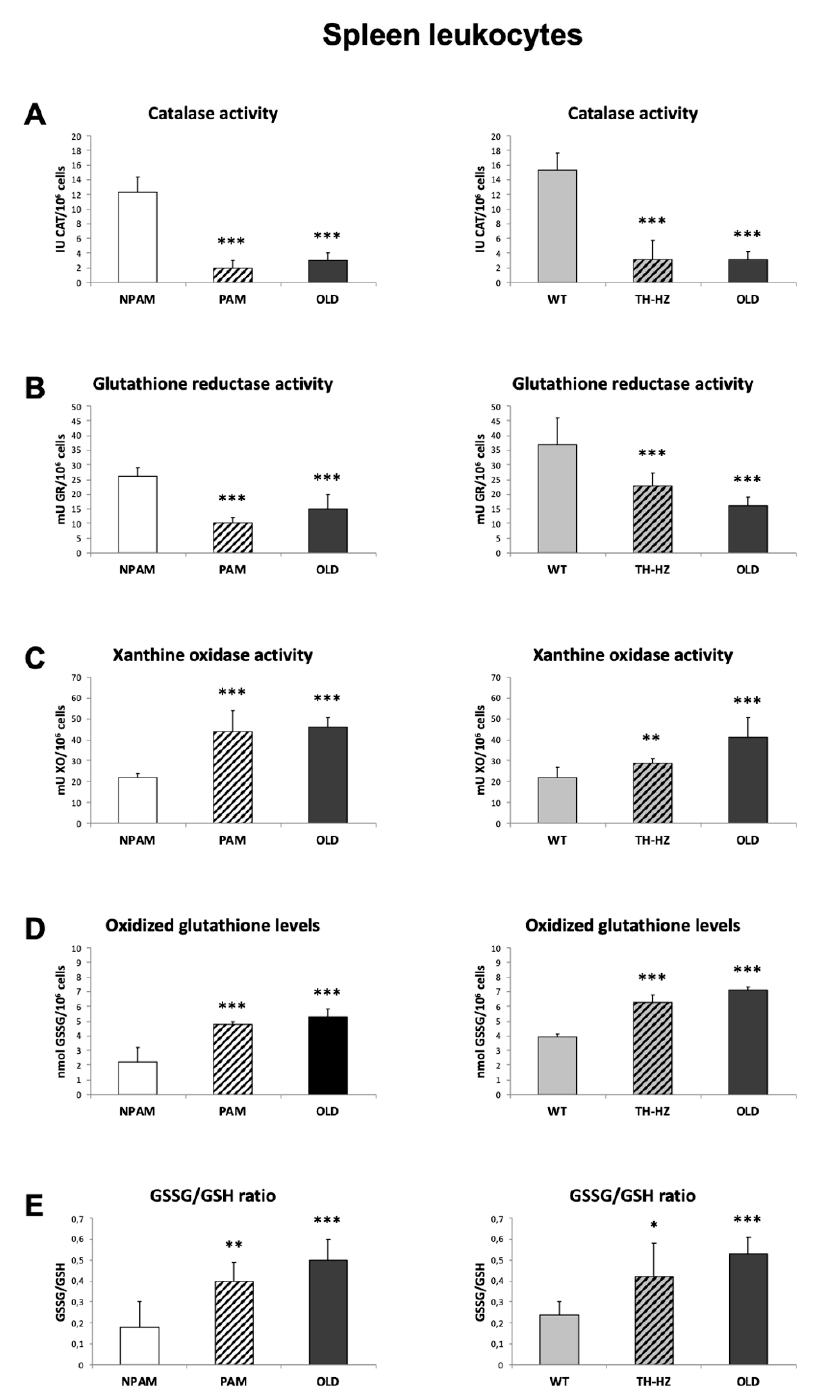
Figure 2. Parameters of redox state in spleen leukocytes. Anti-oxidant defenses: activities of catalase (CAT) (IU CAT/10 6 cells) ( A ) and glutathione reductase (GR) (mU GR/10 6 cells) ( B ); oxidants: activity of xanthine oxidase (XO) (mU XO/10 6 cells) ( C ), and concentrations of oxidized glutathione (GSSG) (mmol GSSG/10 6 cells) ( D ), as well as redox balance (GSSG/GSH ratios) ( E ) in spleen leukocytes from adult PAM, NPAM, TH-HZ, and WT mice and from old mice. PAM: prematurely aging mice, NPAM: non-prematurely aging mice, TH-HZ: tyrosine hydroxylase hemi-zygotic mice, WT: wild-type mice. Each column is the mean ± SD of the values of 10 experiments corresponding to 10 animals. * p < 0.05, ** p < 0.01, *** p < 0.001 with respect to the corresponding controls.